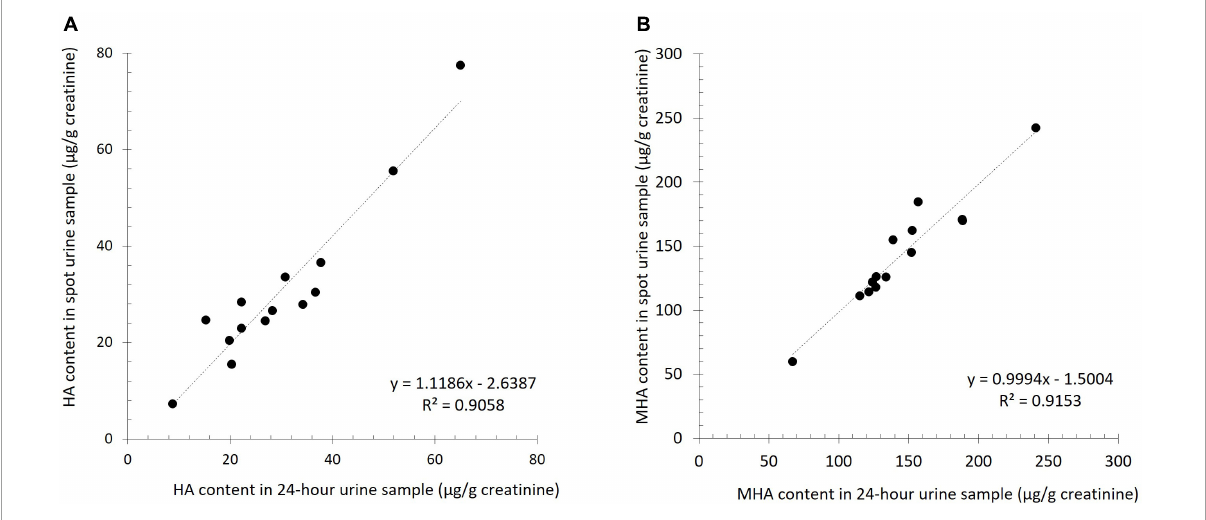
FIGURE1 Linear correlation for the urinary excretion of histamine (HA, A ) and 1-methylhistamine (MHA, B ) between spot urine samples and 24 h urine samples.